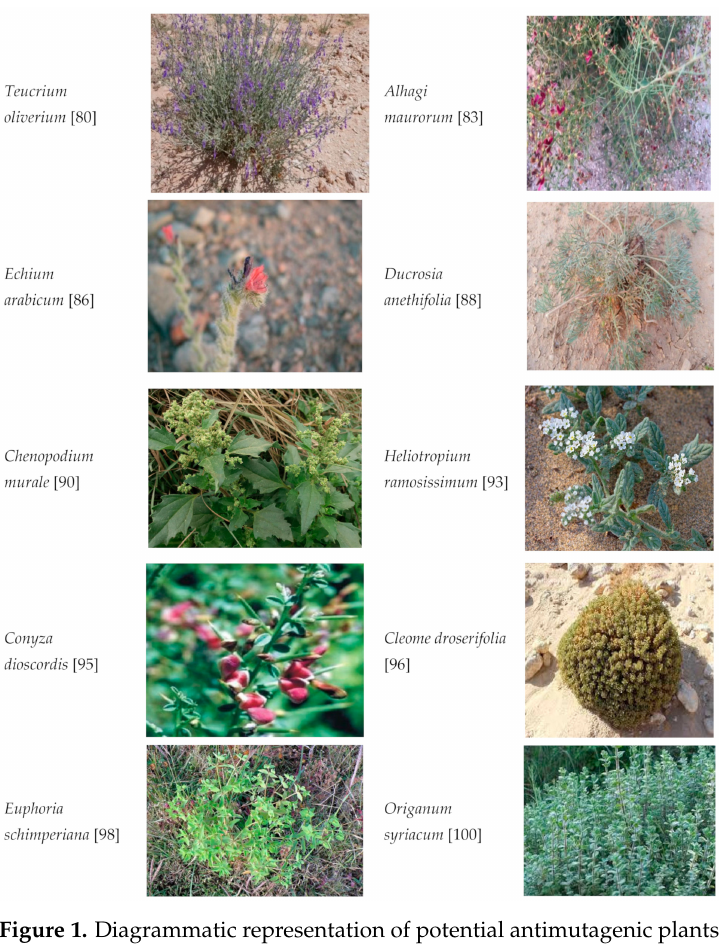
Figure 1. Diagrammatic representation of potential antimutagenic plants of Saudi Arabia.